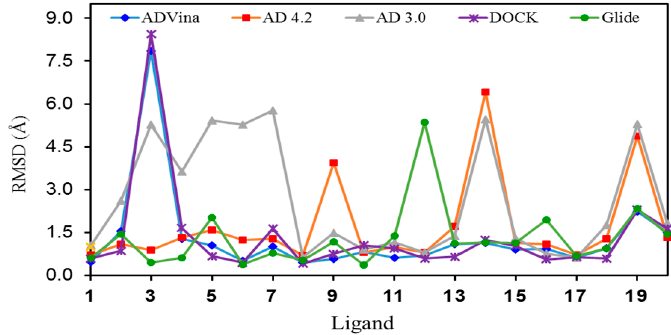
Figure 3. Graphic representation of the RMSD values for the lowest energy pose of each ligand ( 1 – 20 ) in their binding sites.